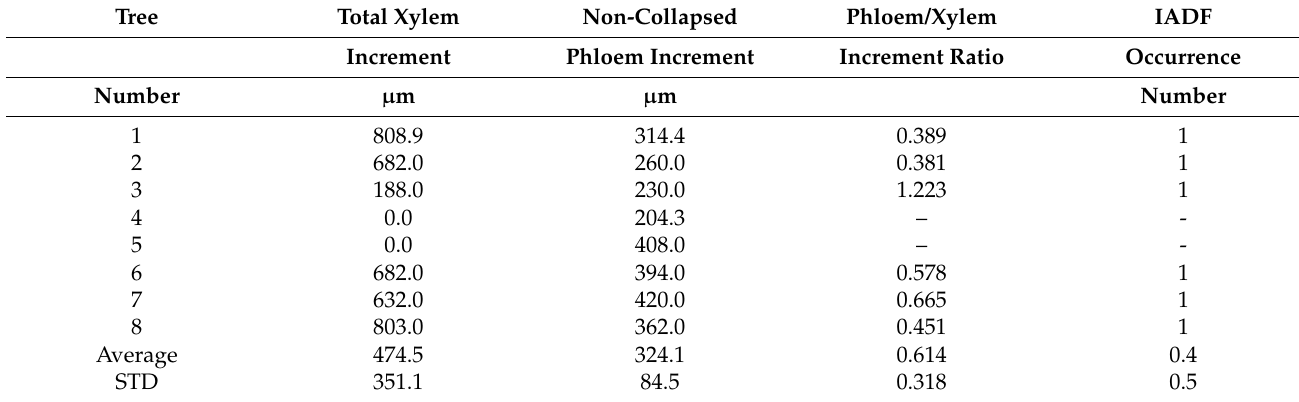
Figure 6. Q. ilex cross-sections with ( A ) development of PC cells stained with astra blue in October; ( B ) the same section region as in (A) but observed in polarised light; ( C ) formation of developing phloem fibres PF stained with safranin and astra blue in November; ( D ) the same wood region as in ( C ) but under polarised light. ( E ) Total wood increment (yellow dashes) with IADF (red dashes) formed during the year 2017. Scale bars = 100 μ m. Table 1. Width of total growth increments in the wood and non-collapsed phloem, their ratio, and occurrence of IADFs on the last sampling date at the end of 2017.